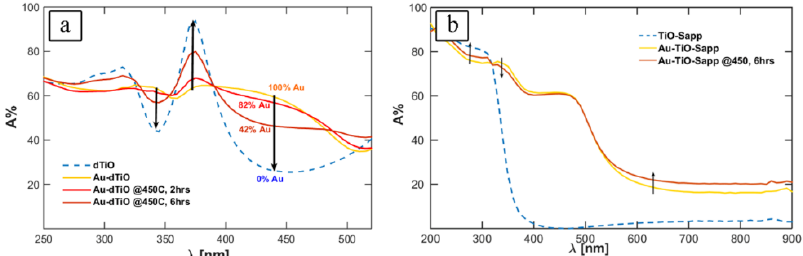
Figure 6. ( a ) Optical absorption spectrum of dTiO and Au-dTiO samples; and ( b ) optical absorption spectrum of TiO-Sapp and Au-TiO-Sapp samples. Reproduced from [71]. with permission from Elsevier, 2018.